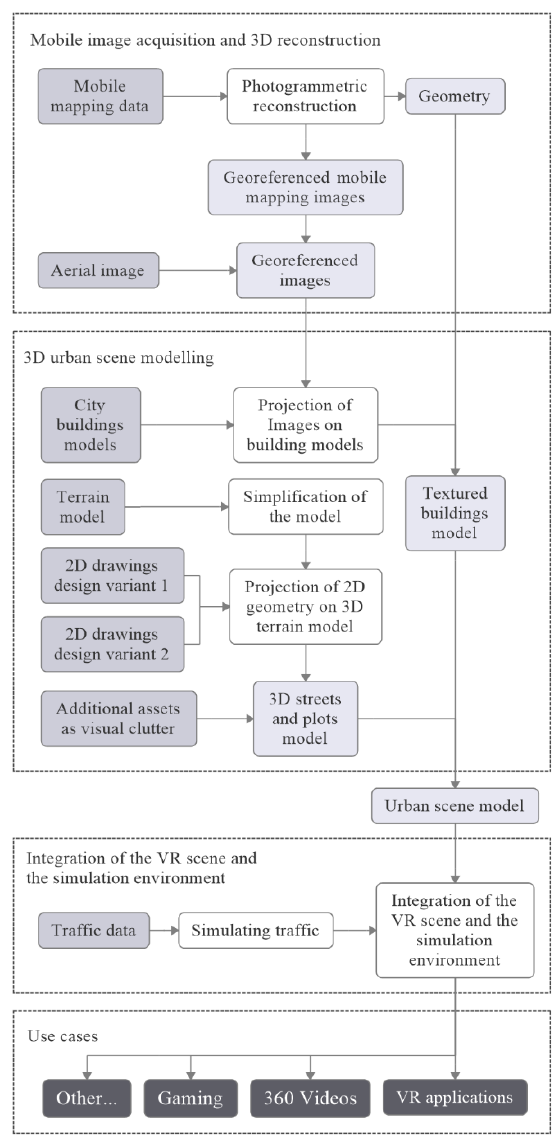
Figure 2. Representation of the main activities and work packages as workflow to obtain the VR simulation environment